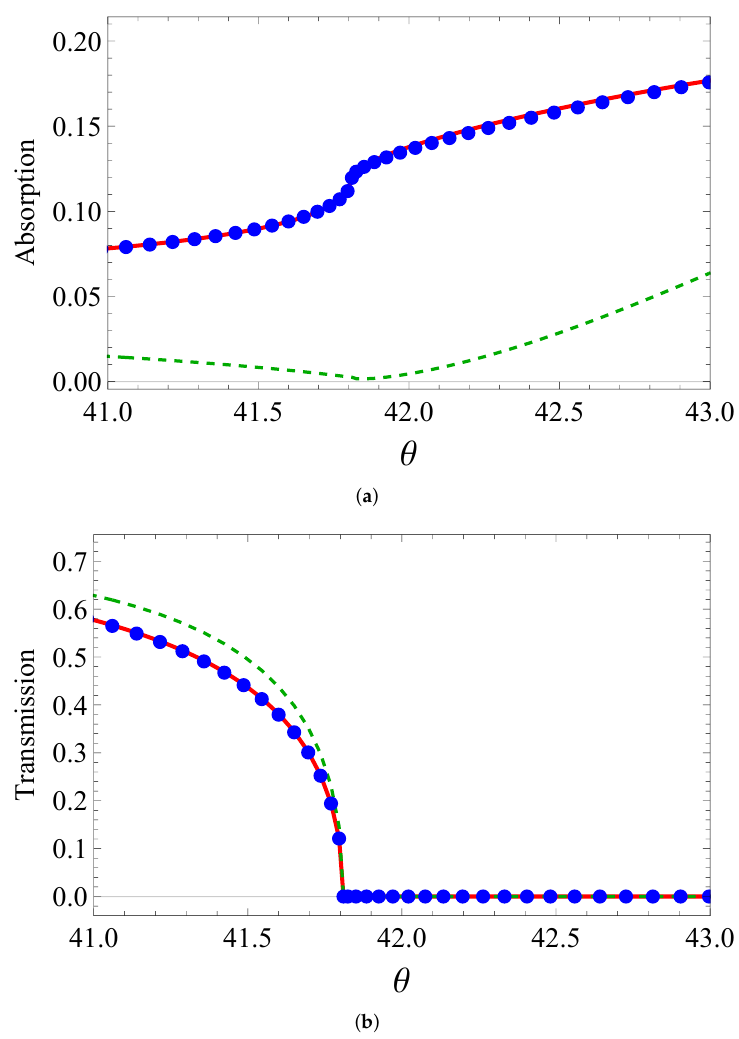
Figure 5. Same as in Figure 4, but for elliptic cylinders with vertical orientation of large